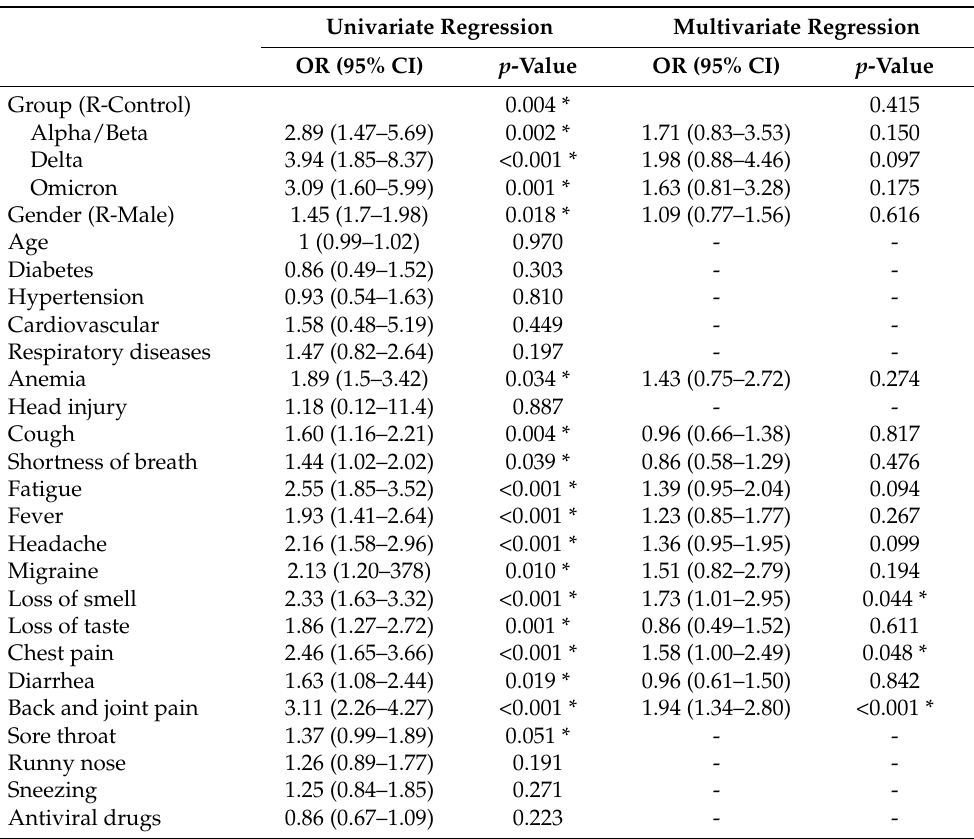
Table 3. Univariate and multivariate binary logistic regression for auditory symptoms (hearing loss, tinnitus, and aural